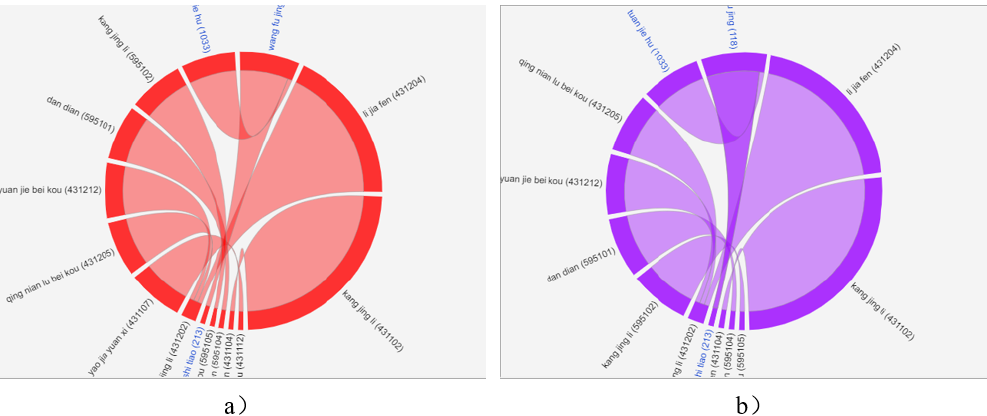
Figure 8. Origin-destination chord view of single cards ( a ) Card number 30527791, ( b ) Card number 1126321.